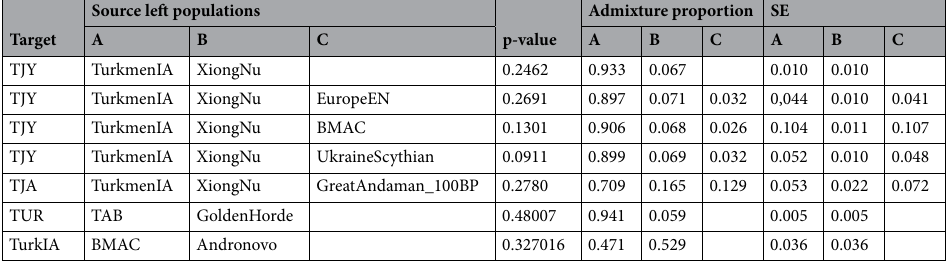
Table 1. Plausible models for Yaghnobis (TJY), Tajiks (TJA, TAB), Turkmens (TUR) and Turkmenistan_IA (TurkIA) as a mixture of two or three sources obtained with qpAdm.